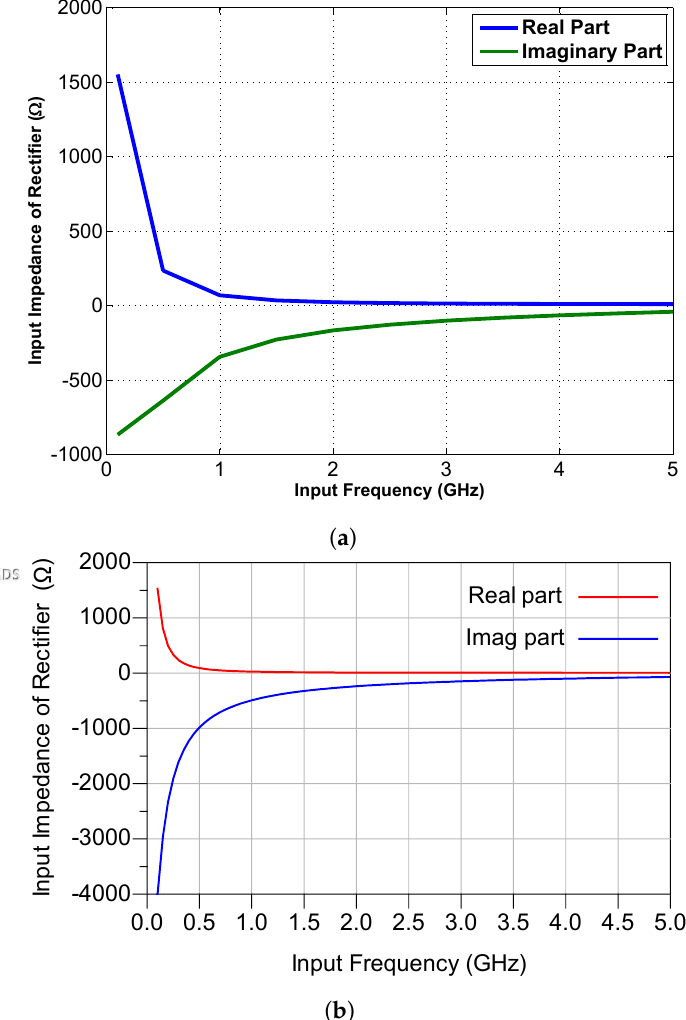
Figure 3. Input impedance of rectifier vs. input frequency under 0 dBm input power. ( a ) Model results. ( b ) Simulation results.